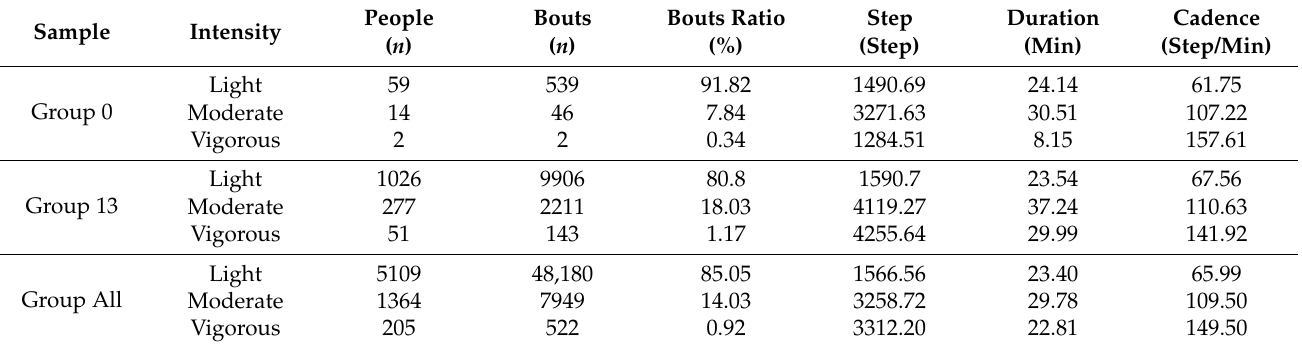
Table 4. Comparing measures of sample groups’ park walking, categorized by the level of